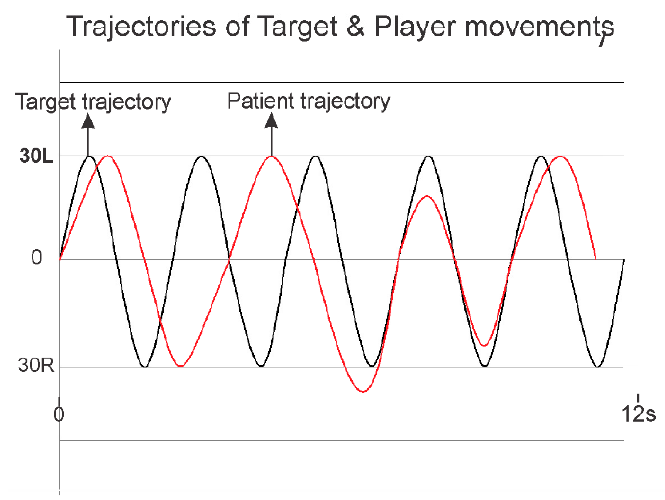
Figure 2. Illustration of an assessment using the cyclic tracking module. In this case, the RMD handle manipulation requires fine rotation using abduction-adduction and flexion-extension of the thumb and fingers. Top right panel shows a screenshot of the tracking task, goal is to track and overlap the game paddle (rectangle object with the moving circle object (computer controlled)). Bottom plots show typical movement trajectory of a healthy young adult performing the tracking task. It is played for 30 s to obtain several continuous tracking cycles for analysis.